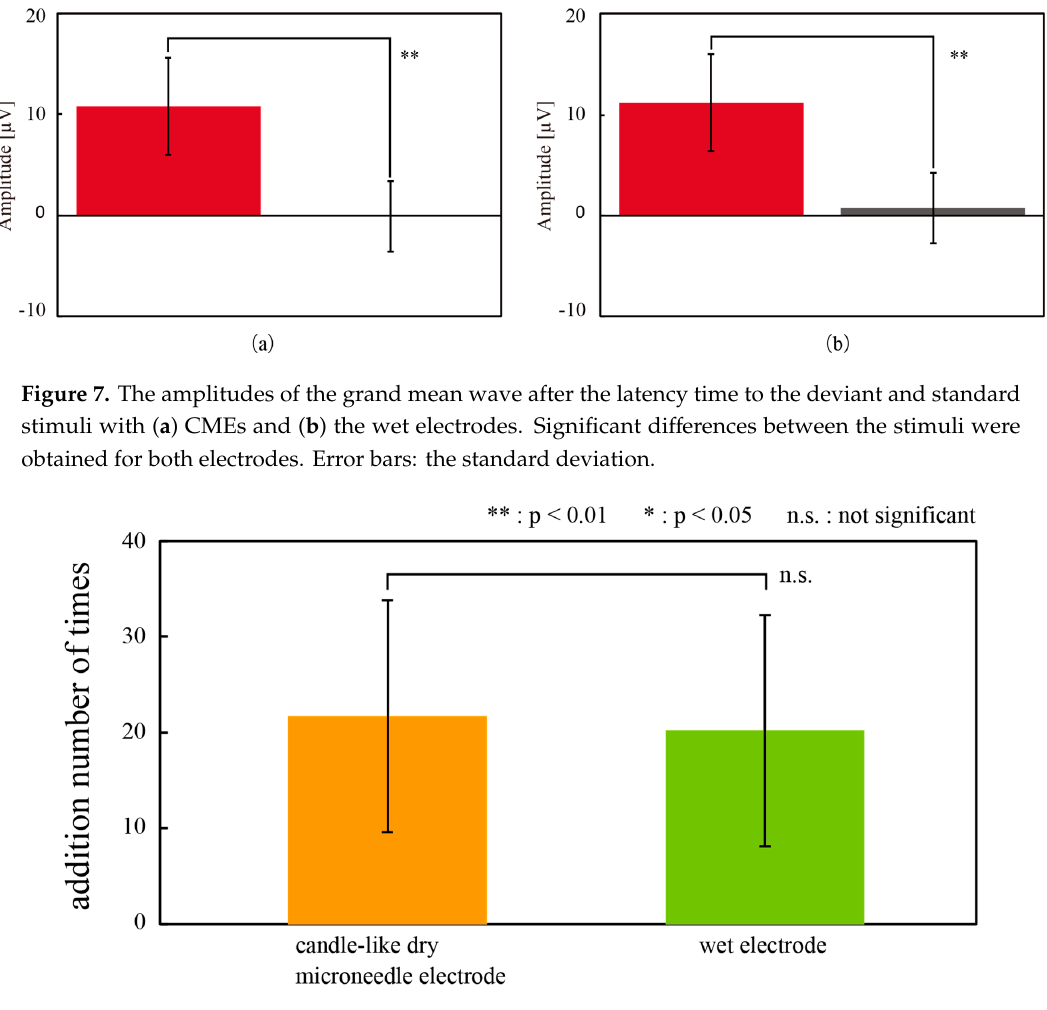
Figure 8. The number of trials required to extract ERPs with statistical significance with the averaging method. CMEs and the wet electrodes showed similar efficiency. Error bars: the standard deviation.